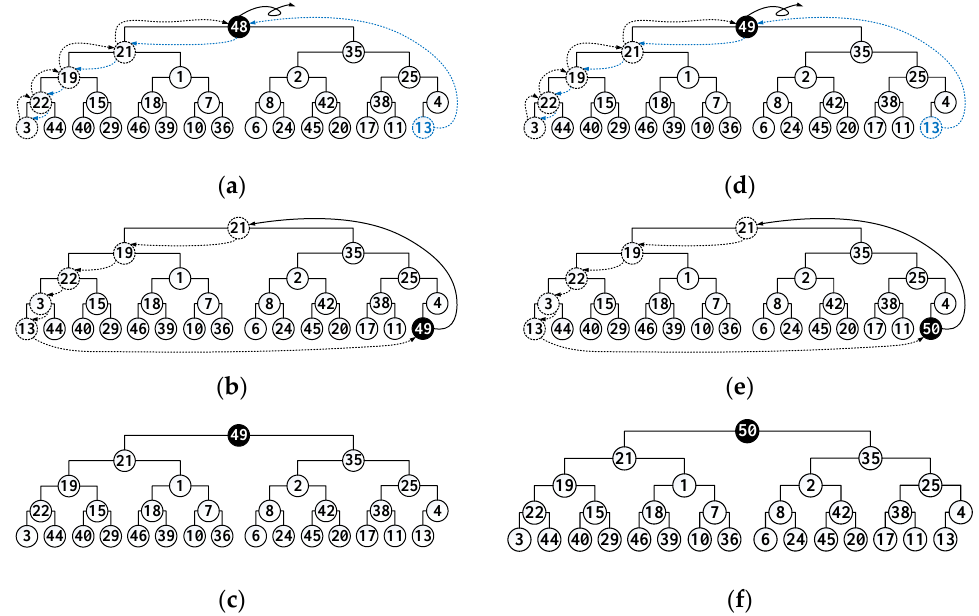
Figure 5. Heap structure updating processes of the priority queue from 48th to 50th sequentially in SNIC. ( a ) Popping 48th from Q ; ( b ) pushing 49th on Q ; ( c ) a temporary state after sorting 49th in Q ; ( d ) Popping 49th from Q ; ( e ) pushing 50th on Q ; ( f ) a temporary state after sorting 50th in Q . Solid elements indicate that they are newly inspected and pushed in the current step, and their storage location is redirected by solid arrows. Other hollow nodes represent the elements that are inspected before but not labeled. Note that 13th is the last leaf node which recursively executes a sift-up or sift-down operation to modify the structure redirected by dotted arrows, as well as some of hollow nodes with dotted outlines.